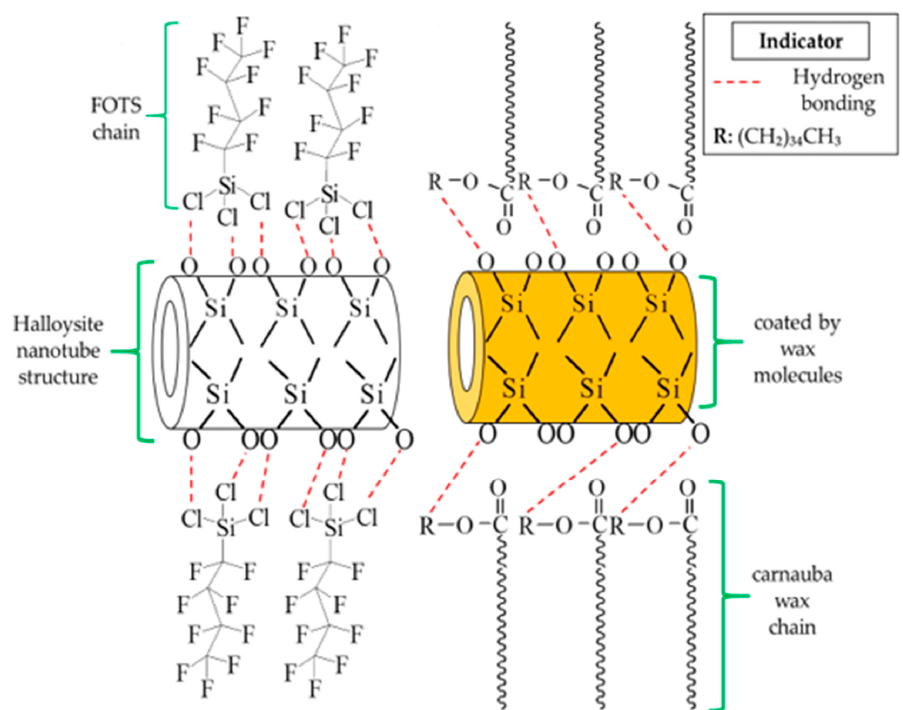
Figure 5. Illustration of proposed interaction of functionalized FOTS and carnauba wax with HNT. The hydrogen bonding takes places in both reactions of functionalized HNTs. The solid form of carnauba wax promotes the coating process on the surface of HNT particles. The functionalization process has facilitated the formation of hydrophobic HNT particles.